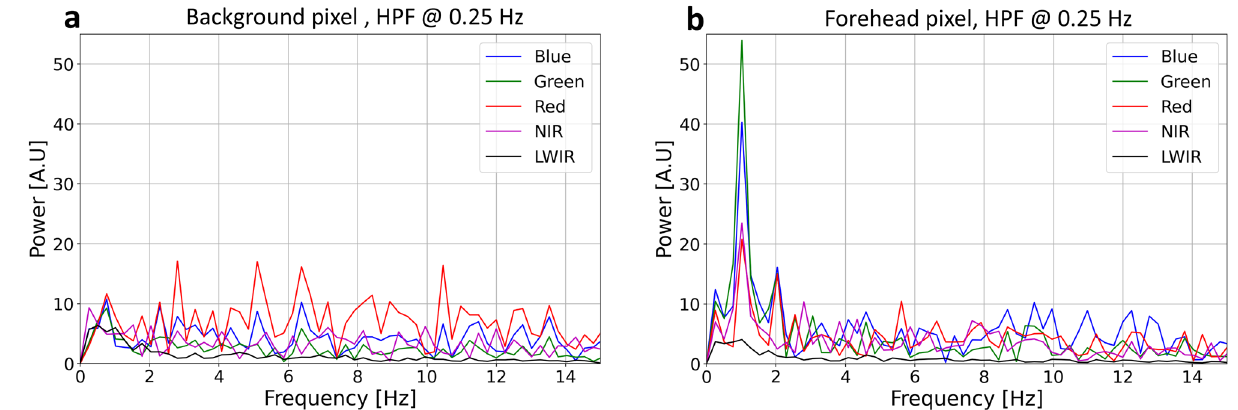
Figure 10. The frequency domain spectrum powers of ( a ) a background pixel signal (located at a wall behind the viewer’s face), and ( b ) a facial skin pixel